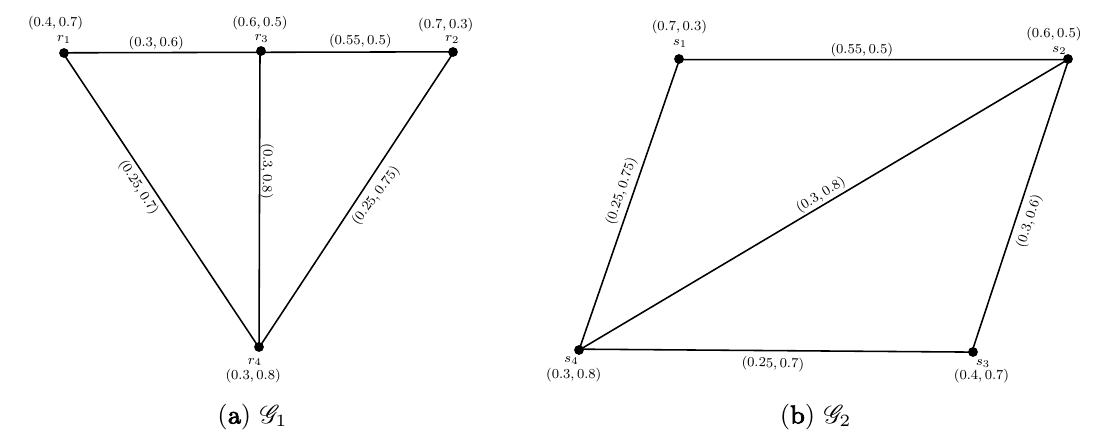
Figure 6.1: Pythagorean fuzzy planar graphs Figure 12. Pythagorean fuzzy planar